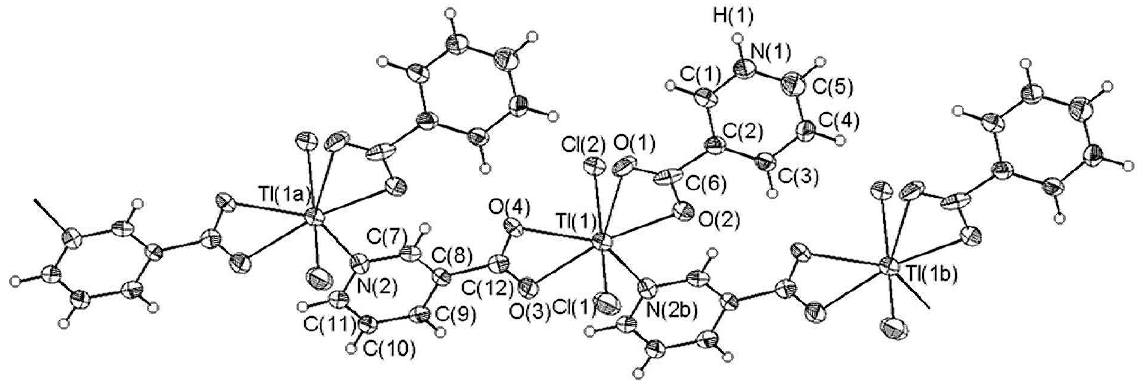
Fig. 2 A fragment of the chain polymeric association in [TlCl 2 (nic)(Hnic)] ( 2 ). The atoms are drawn with 40% probability